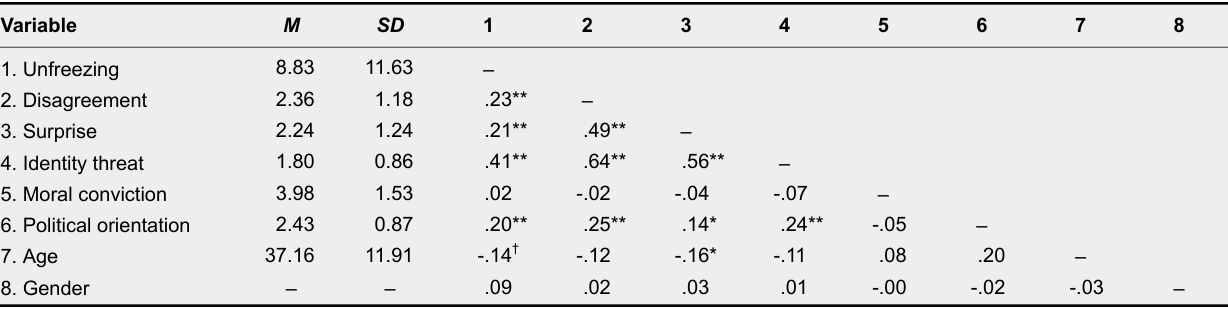
Descriptive Statistics and Bivariate Correlations Between